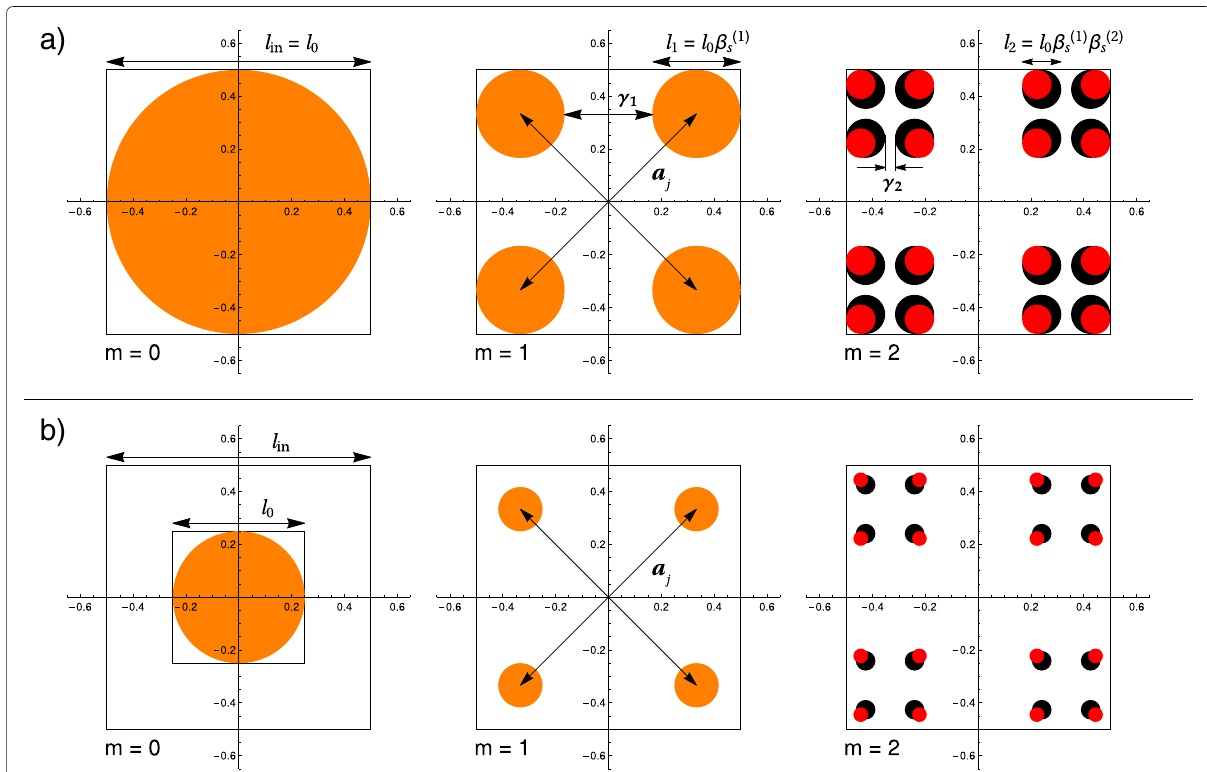
Fig. 1 (Color online) A comparison between regular and fat fractals for the first two iterations, where the basic shape at m = 0 is a disk of diameter l 0 and the fractal size is l in : a l 0 = l in ; b l 0 = l in / f , with f = 2. In both cases, at m = 1 the structures coincide due to equal scaling factors β ( 1 ) s . Starting with m = 2, the fat fractal has a bigger scaling factor regular fractal ( reddisks ); a j are the position vectors and γ i are the fractions of removed length at i th